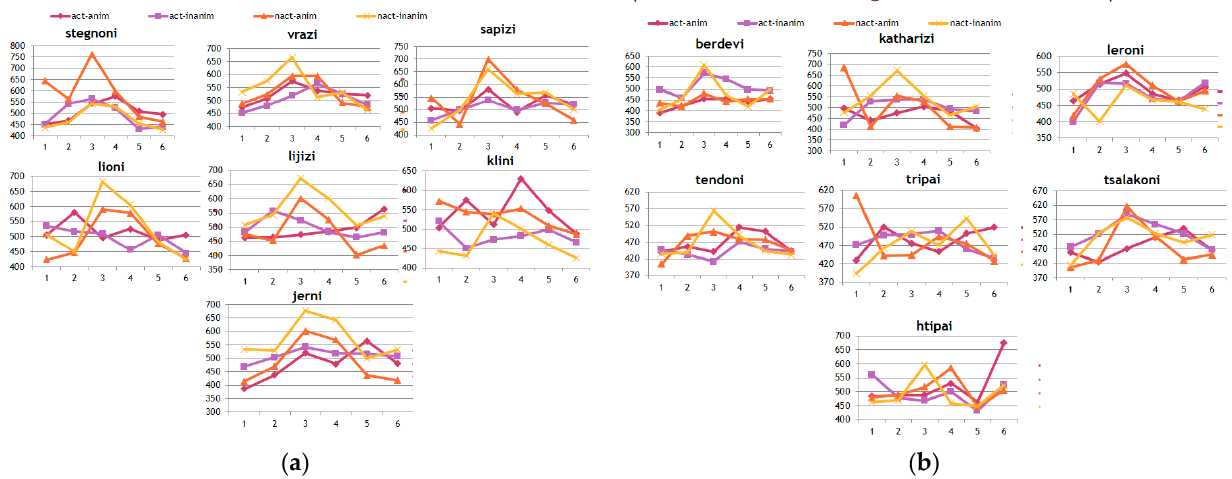
Figure 4. Mean RT lines for individual verbs: ( a ) ‘voice non-alternating’ anticausatives; ( b ) ‘voice alternating’ anticausatives.